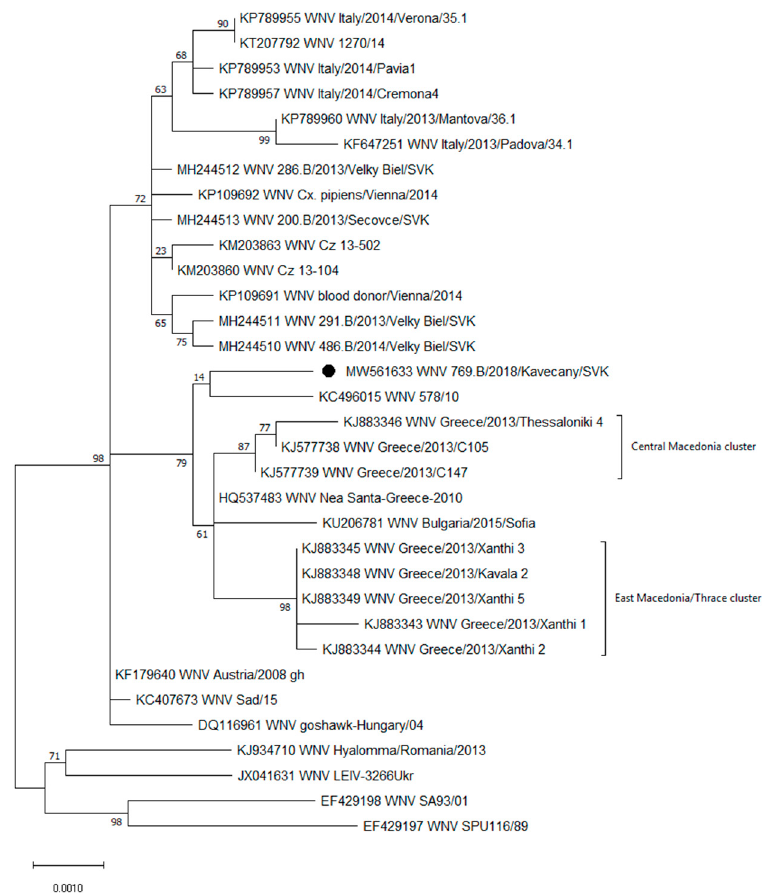
Figure 1. The maximum likelihood phylogenetic tree based on West Nile virus (WNV) lineage 2 complete polyprotein amino acid sequences indicating the phylogenetic placement of the new cell culture isolate 769.B/2018/Kaveˇcany/SVK, which is marked with a point. Clusters are labeled according to